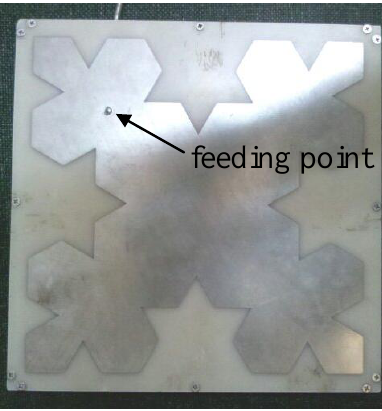
Figure 4. Picture of the designed antenna.